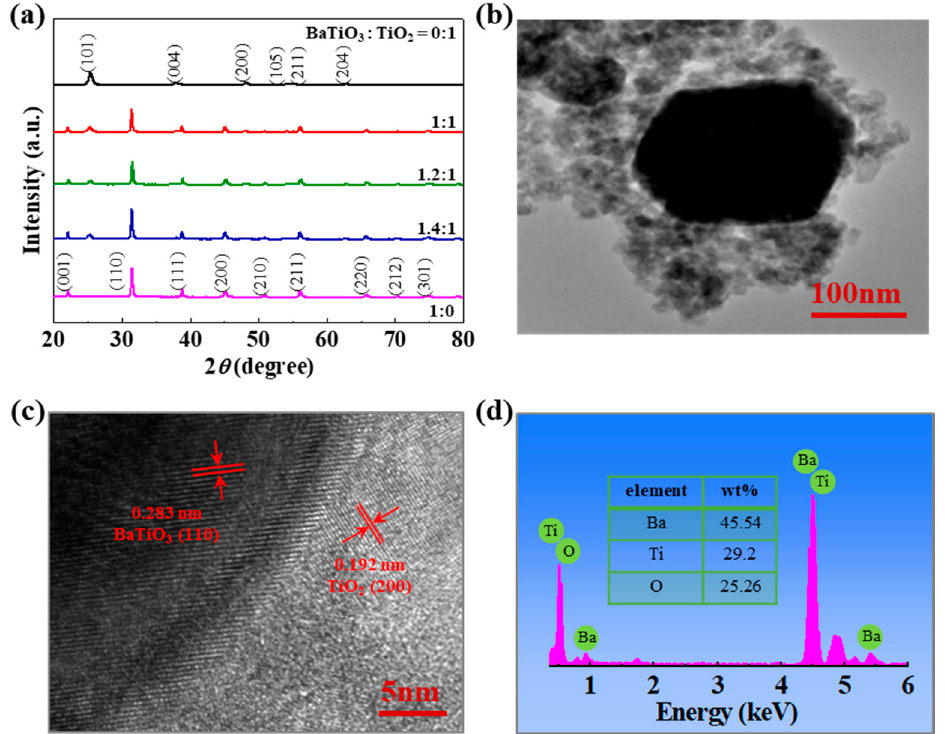
Figure 1. ( a ) X-ray diffraction (XRD) patterns of the as-synthesized BaTiO 3 -TiO 2 composites and TiO 2 nanoparticles, and commercial BaTiO 3 crystallines after being subjected to the hydrothermal process. high resolution transmission electron microscope (HRFEM)images at low solution ( b ) and high solution ( c ) of the BaTiO 3 -TiO 2 composite (1.2:1), ( d ) energy dispersive X-ray spectrometry (EDS) analysis of the BaTiO 3 -TiO 2 composite.